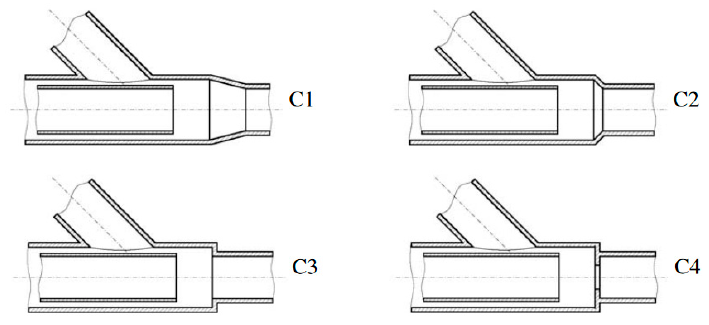
Figure 13. Two-phase mixing pipes with di ff erent shapes [54].